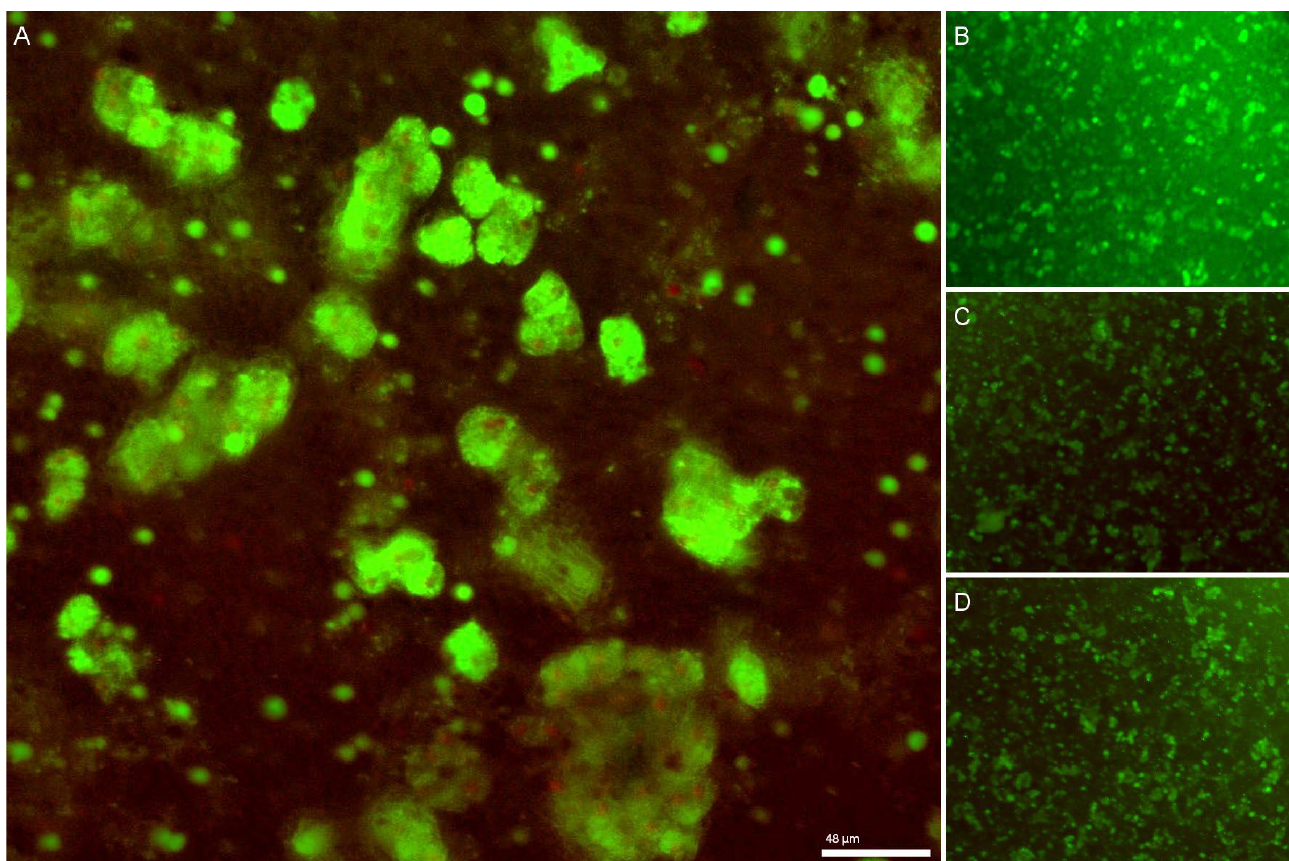
Figure 5. ( A ) Live-dead staining 24 h post culture reveals viable liver cells (green fluorescence) along with debris and dead cells (red stains) (20× zoom). ( B – D ) Cells in other wells demonstrating a mixture of live and dead cells.